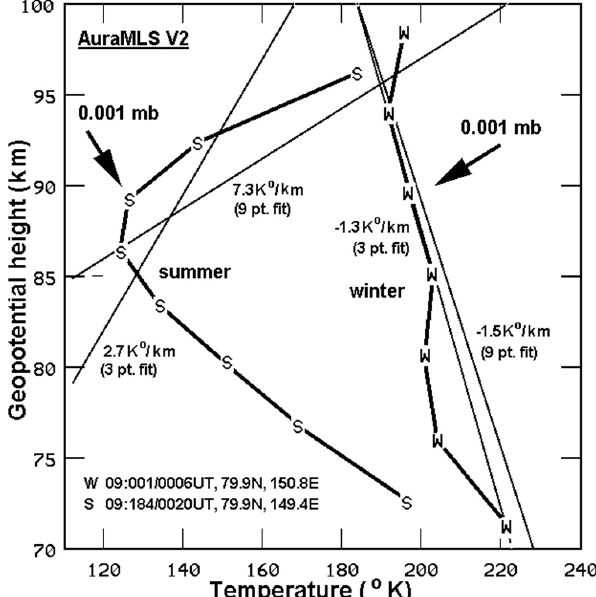
Fig. 2. Illustration of the 3 pt. fit and 9 pt. fit gradient calculation methods on MLS winter and summer temperature profiles.